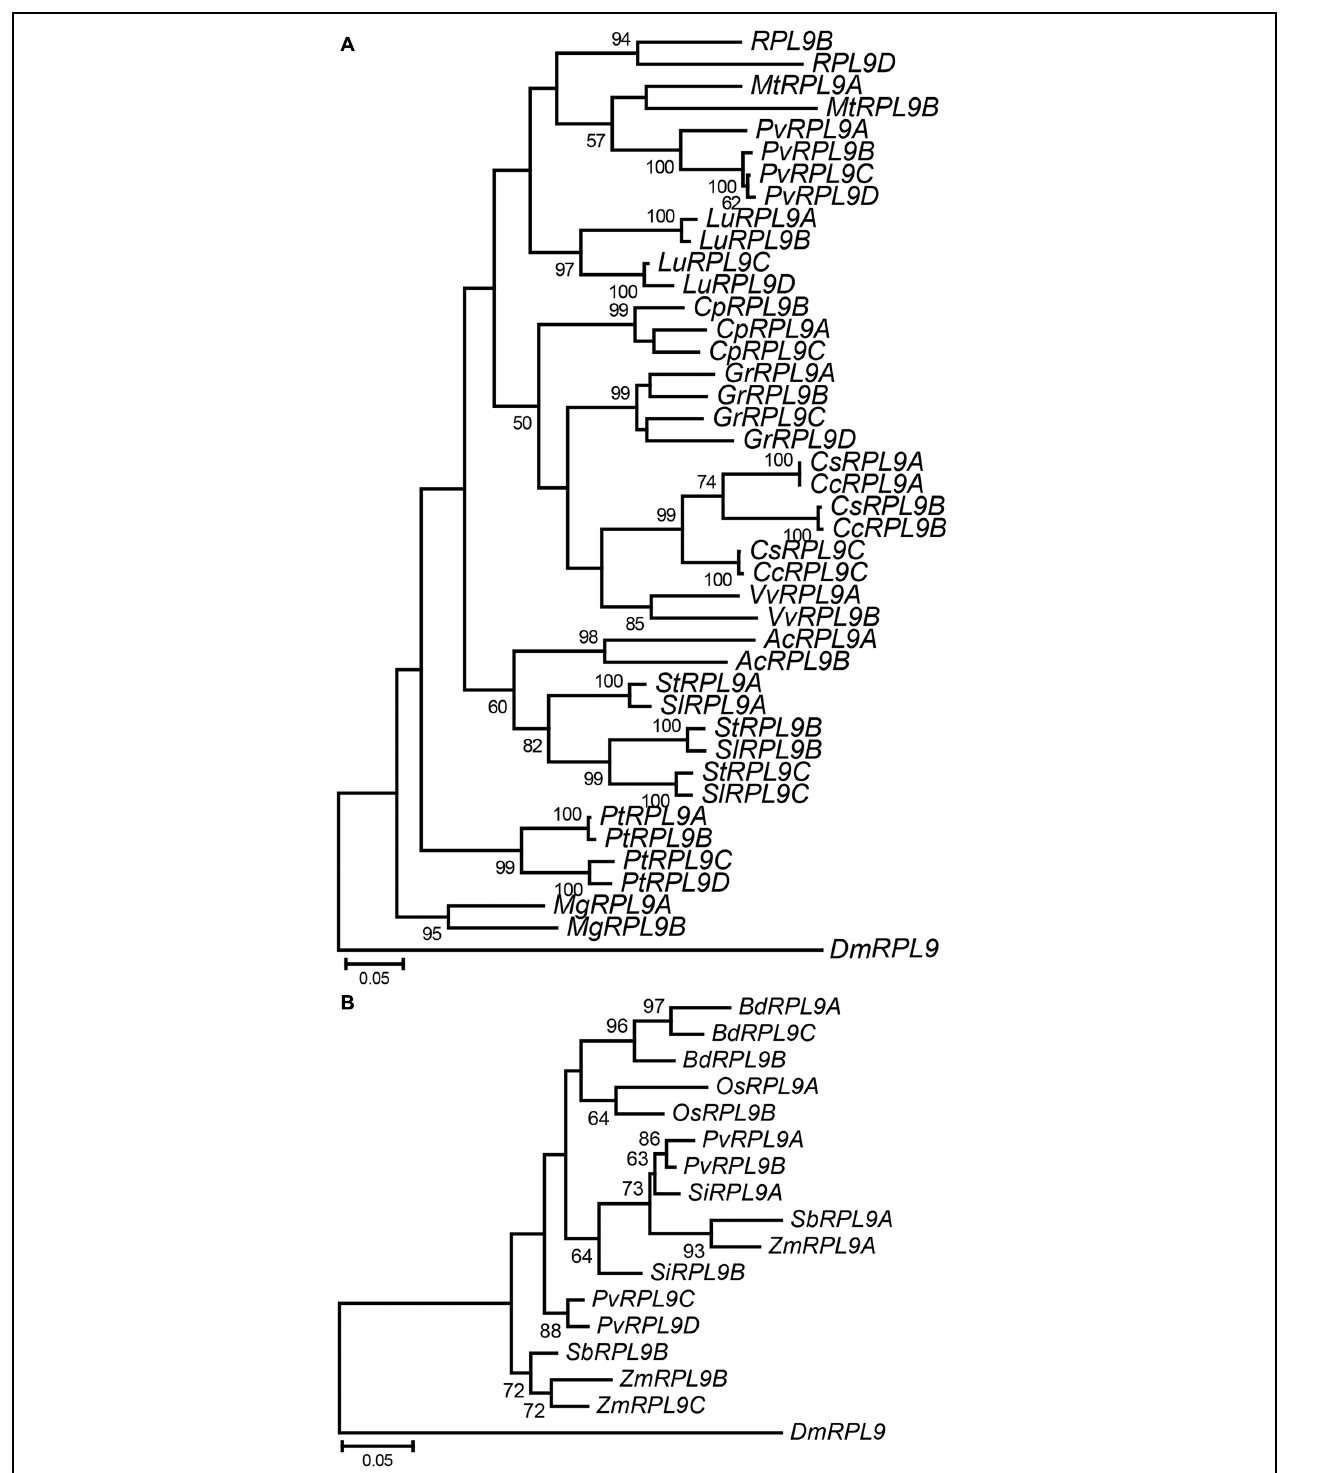
FIGURE 4 | Phylogeny of RPL9 genes from angiosperm species. Tree for dicot species (A) Aquilegia coerulea ( AcRPL9 ) , Carica papaya ( CpRPL9 ) , Citrus clementina ( CcRPL9 ) , C. sinensis ( CsRPL9 ) , Gossypium raimondii ( GrRPL9 ) , Linum usitatissimum ( LuRPL9 ) , Medicago truncatula ( MtRPL9 ) , Mimulus guttatus ( MgRPL9 ), P. vulgaris ( PhvRPL9 ) , Poplar trichocarpa ( PtRPL9 ) , Solanum lycopersicum ( SlRPL9 ), S. tuberosum ( StRPL9 ), and Vitis vinifera ( VvRPL9 ). Tree for monocot species (B) Brachypodium distachyon ( BdRPL9 ) , Oryza sativa ( OsRPL9 ) , Panicum virgatum ( PvRPL9 ) , Setaria italica ( SiRPL9 ), S. bicolor ( SbRPL9 ), and Zea mays ( ZmRPL9 ). D. melanogaster RPL9 gene ( DmRPL9 ) is the outgroup.